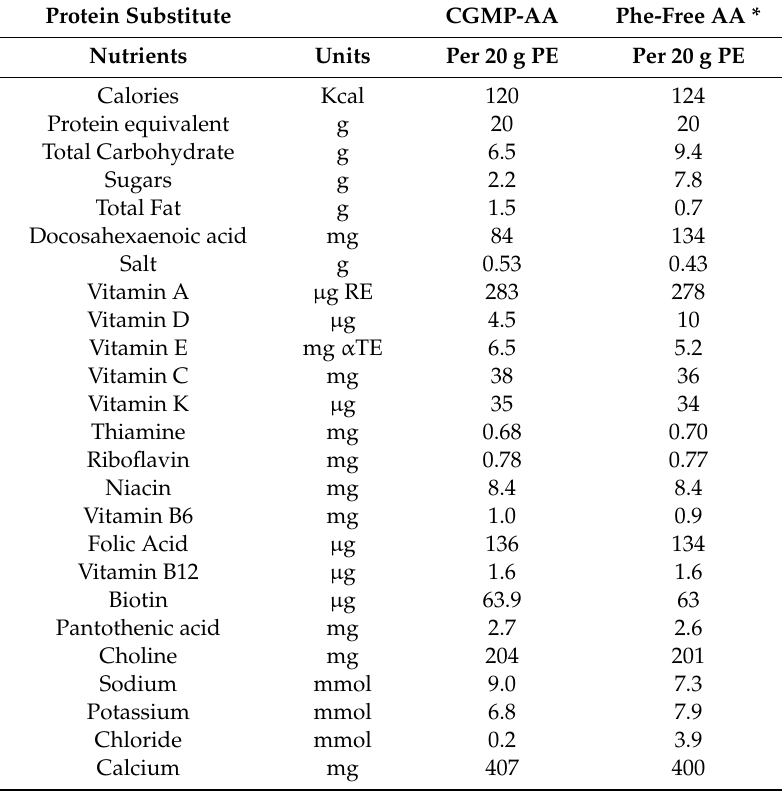
Table 1. The nutrient composition of CGMP-AA compared with conventional AA. Protein